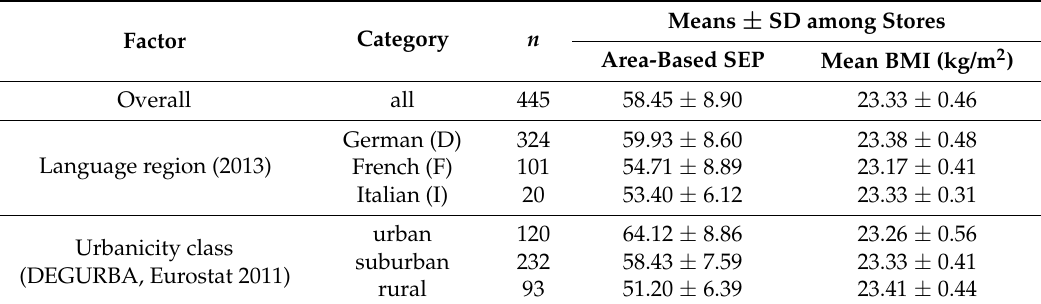
Table 1. Characteristics of the stores included in the data analysis: number ( n ) of stores per language region and urbanicity class as well as means ± SD of the area-based socioeconomic position (SEP, on a scale from 0 to 100) and the mean Body Mass Index (BMI) of conscripts attributed to each store.